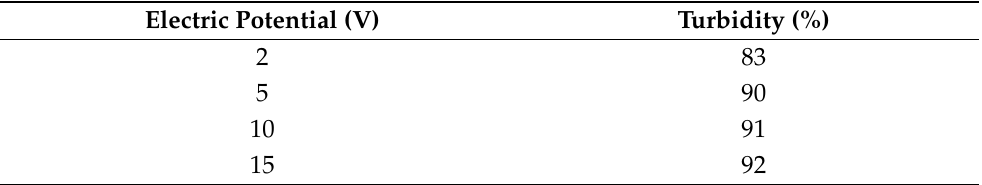
Table 7. Effect of the applied potential difference on the removal of the